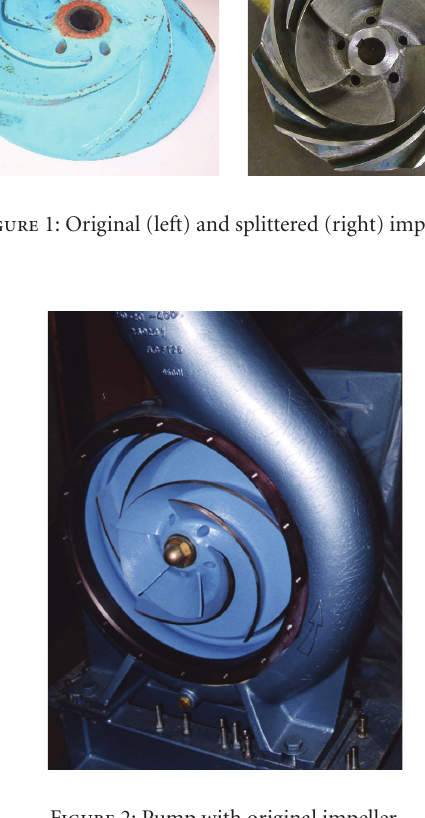
Figure 2: Pump with original